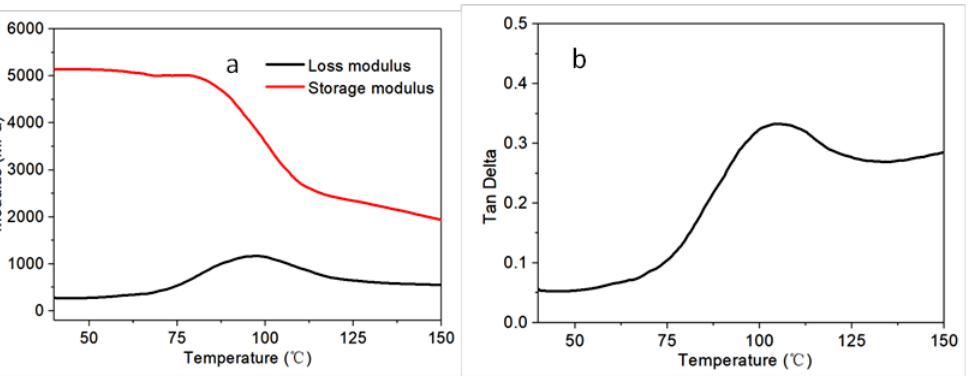
Figure 3. Dynamic mechanical property of the CF/EP composite: The dependence of storage modulus and loss modulus ( a ) and Tan Delta ( b ) on the